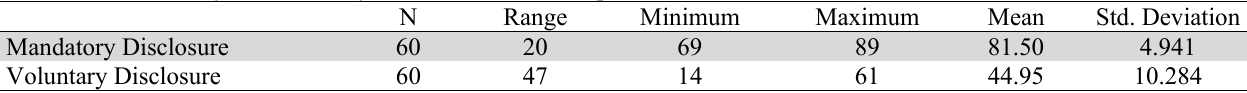
The level of mandatory and voluntary disclosure for the sample N Range Minimum Maximum Mean Std.